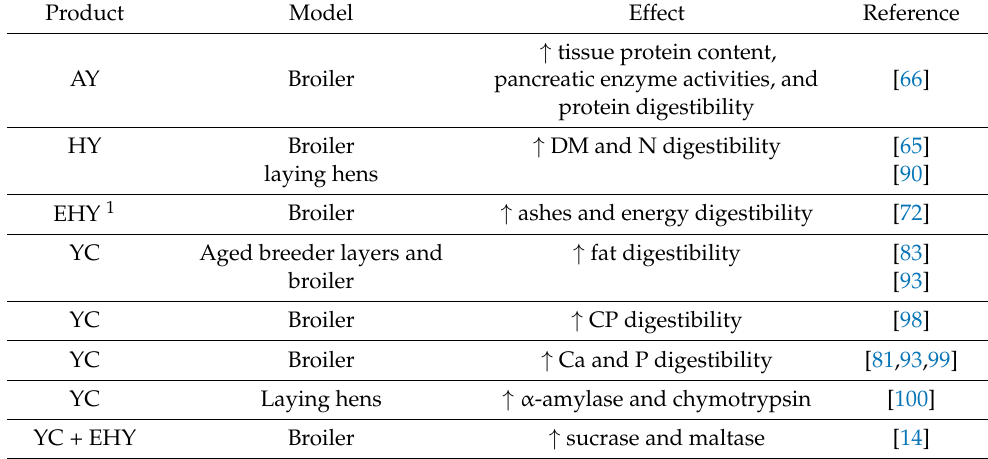
Table 3. Main effects of hydrolyzed-yeast (HY), autolyzed-yeast (AY), and yeast-culture (YC) admin- istration on nutrient digestibility of